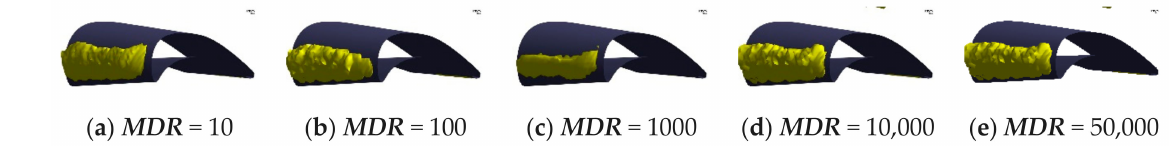
Figure 35. The 10% vapor volume fraction distribution in stator domain at stall under various maximum density